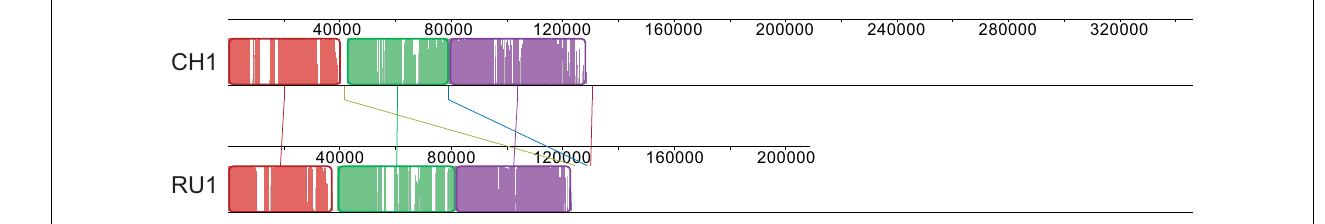
FIGURE 2 |Alignment of CH1 and RU1 contigs that could not be aligned to the reference genome after iterative ordering. Alignment is represented